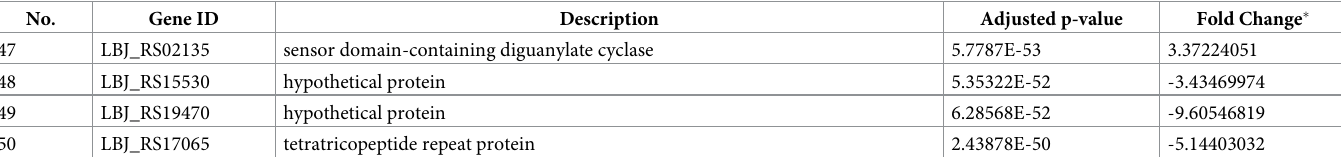
identified as a gene that was significantly DE by RNAseq in HB203 at 37˚C compared to 29˚C (adj. p-value = 1.96E-58, FC = 4.5) ( Fig 5D and Table 5 ). To further investigate and validate expression of LigB as a component of the serovar Hardjo outer membrane, fractions enriched for the outer membrane proteome of HB203 were compared to that of JB197 by 2-D DIGE; a protein spot identified as LigB by mass spectrometry was detected in six biological replicates of HB203 cultured at 29 or 37˚C in larger amounts compared to that of six biological replicates of JB197 (p-value = 2.9E-07, q = 6.3E-07, Power � 0.999, FC = 28.7) ( Fig 5F ). The identification of LigB by mass spectrometry was based on the identification of 26 unique peptides and 110 Peptide Spectrum Match (PSMs) (sequence coverage of this 1896 amino acid protein was 16%). In addition to ligB , qPCR was used to validate expression of lipL45 across all four major contrasts of interest (see above) ( S3 Fig ). Validation of gene expression by qPCR is also pro- vided for LBJ_RS02895 and LBJ_RS11060, ( S4 Fig ); LBJ_RS02895, which encodes a hypotheti- cal protein, was significantly differentially expressed in both 29˚C (JB197 vs. HB203) and JB197 (37˚C vs. 29˚C) contrasts (adj. p-value = 0.0, FC = 220.5, adj. p-value = 1.2E-154, FC = -37.4 respectively). LBJ_RS11060, which also encodes a hypothetical protein, was significantly differentially expressed in the 37˚C (JB197 vs. HB203) contrast (adj. p-value = 3.5E-302, FC =